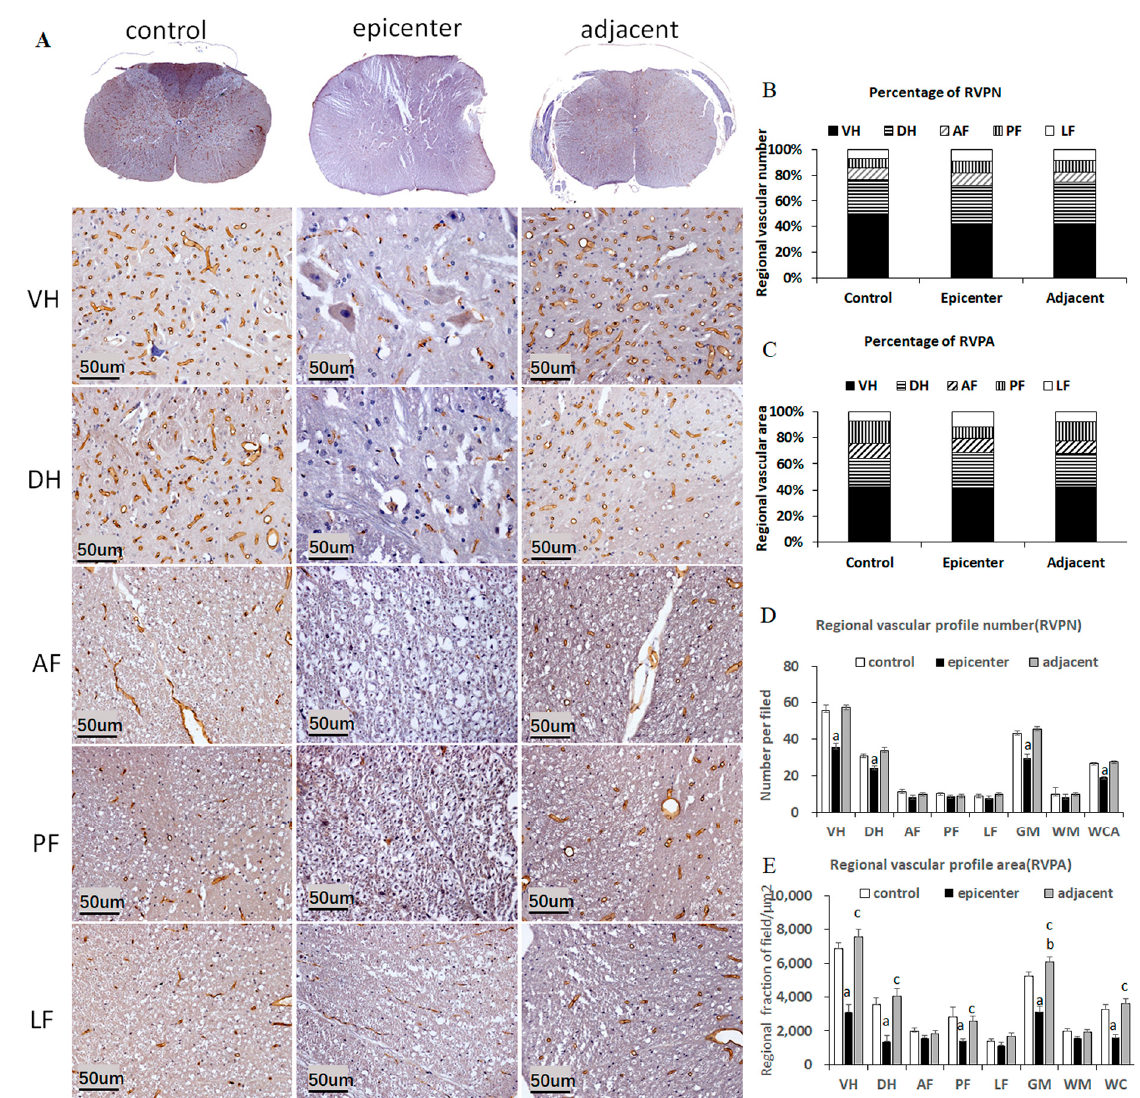
Figure 5. EBA immunoreactivity and microvascular anatomical distribution. ( A ) EBA immunoreactivity in different anatomic regions and groups. RVPN ( B )/RVPA ( C ) anatomic distribution. The largest proportion of blood vessels is located in GM, especially in VH. ( D , E ) Quantitative analysis of blood vessels in different anatomic regions. The RVPN/RVPA decreased significantly in the VH and DH of the compressive epicenter, whereas increased they in the adjacent level. Data are presented as mean values ± SE for standardized ×20 microscopic fields (0.0694 mm²); “a, b”, different from control group; “c”, adjacent level different from the compressive epicenter ( p < 0.05, repeated measures ANOVA followed by Bonferroni tests). Note: “VH”, ventral horn; “DH”, dorsal horn; “AF”, anterior funiculus; “PF”, post funiculus; “LF”, lateral funiculus.